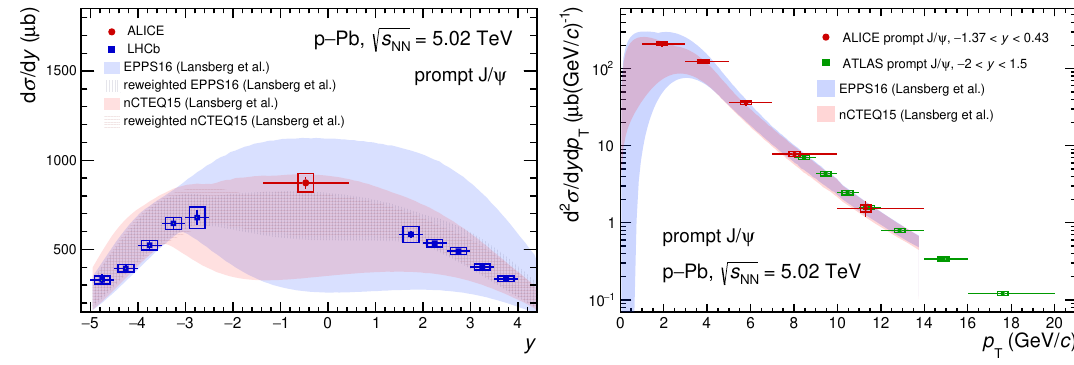
Figure 5 . d σ / d y as a function of the rapidity in the centre-of-mass frame (left panel) as prompt J /ψ obtained in this work at midrapidity and by the LHCb collaboration in the forward and backward rapidity regions [64], and d 2 σ / d y d p as a function of p (right panel) compared with AT- prompt J /ψ T T LAS results [14] (reported up to p = 20 GeV/ c ). The vertical error bars and the boxes on top of T each point represent the statistical and systematic uncertainties. In the left plot, the systematic un- certainty of the ALICE data point includes also the contribution from the extrapolation procedure to go from the visible region ( p > 1 GeV/ c ) to p > 0 , as described in the text. For the measurements T T as a function of p , the data symbols are placed within each bin at the mean of the p distribution T T determined from MC simulations. The results of a model [100–103] including nuclear shadowing based on the EPPS16 [95] and nCTEQ15 [104] nPDFs are shown superimposed on both panels (see text for details). In the right panel, the computations refer only to the ALICE rapidity